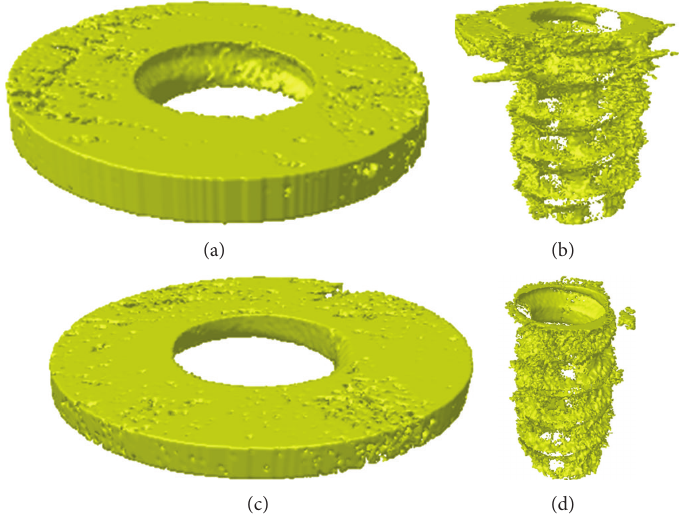
Figure 3: 3D micro-CT images of bone microarchitecture determined by the volume of interest (VOI). (a) Cortical bone area in control group. (b) Bone marrow area in control group. (c) Cortical bone area in diabetic group. (d) Bone marrow area in diabetic group.